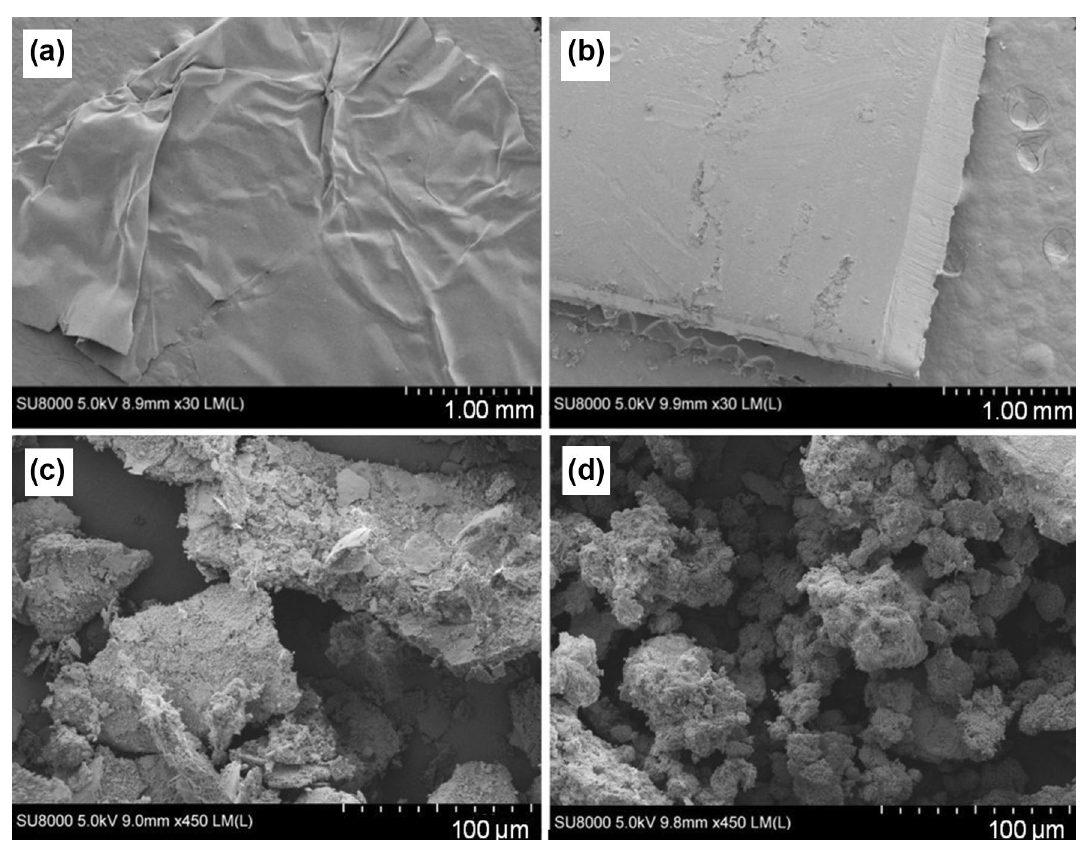
Fig. 7 SEM images of a aluminum foil and b aluminum casing before reaction, and solid products from reactions at 340 °C for 1 h using c alu- minum foil and d aluminum